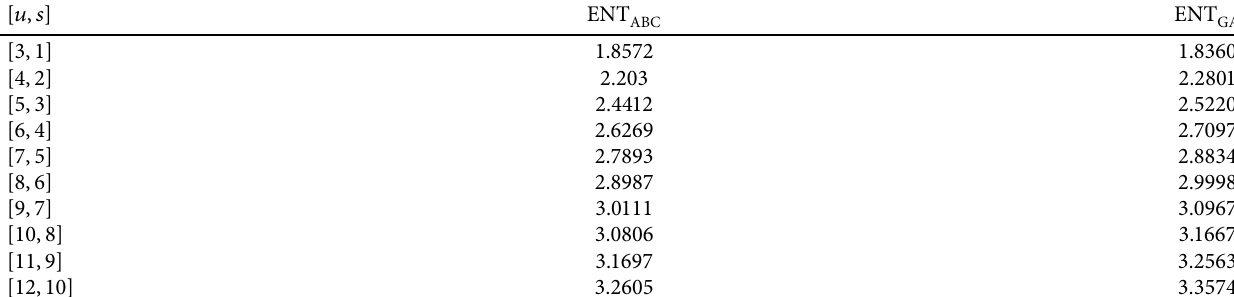
and ENT entropies for C ABC GA